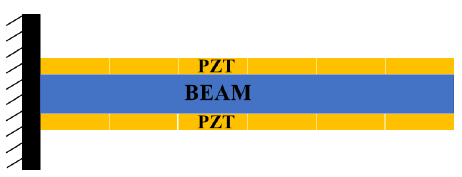
Figure 1. The piezoelectric coupled beam.